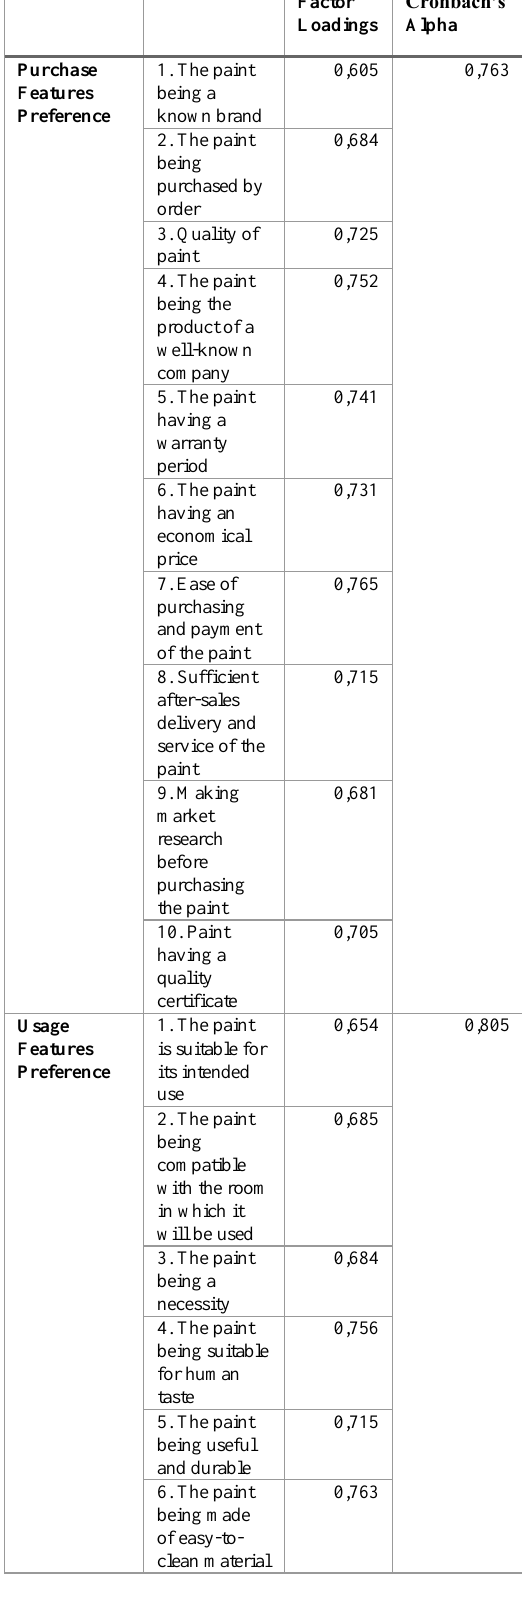
Factor Cronbach’s Loadings Alpha